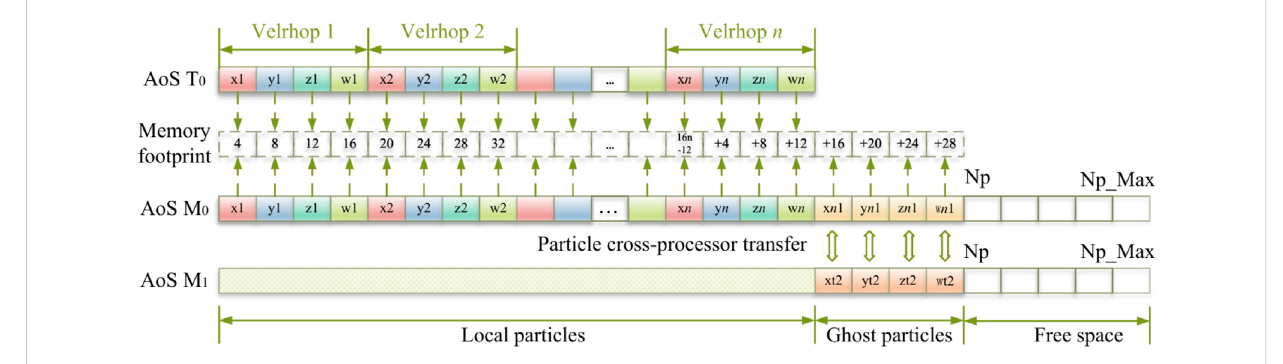
FIGURE 3 The particle storage structure for